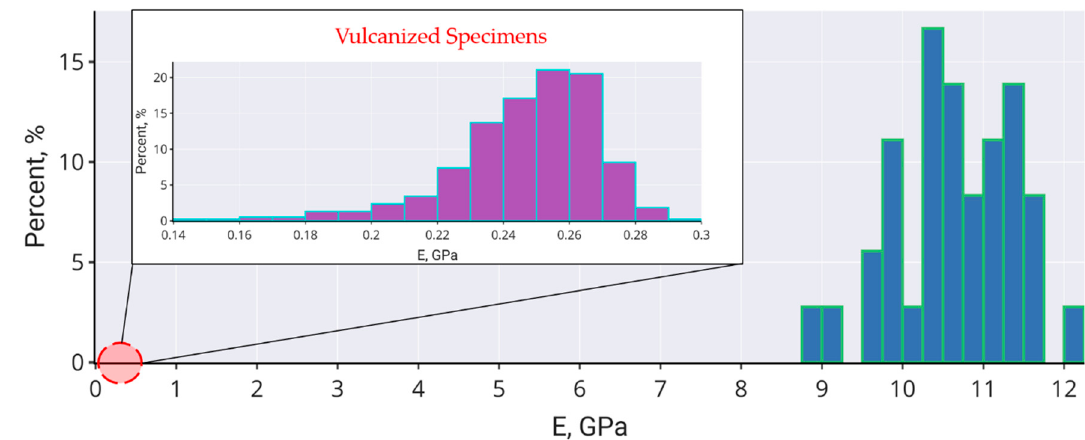
Figure 8. The Young’s modulus distribution of vulcanized (purple) and carbonized (blue) specimens of EC-FC-1 composite.